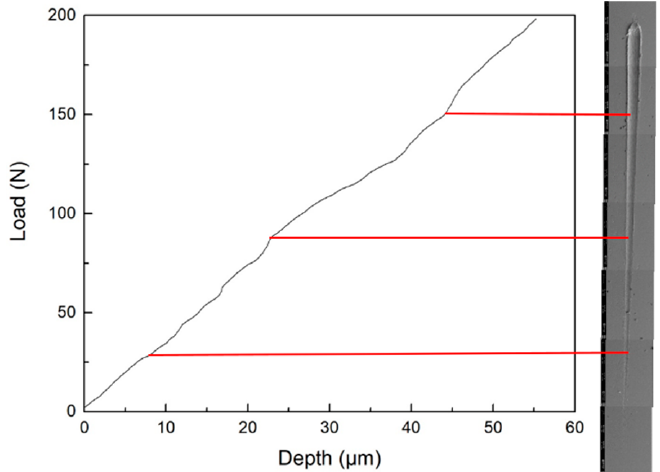
Figure 5. Scratch load vs. penetration depth with the optical aspect of the scratch trace and the indication of critical loads.